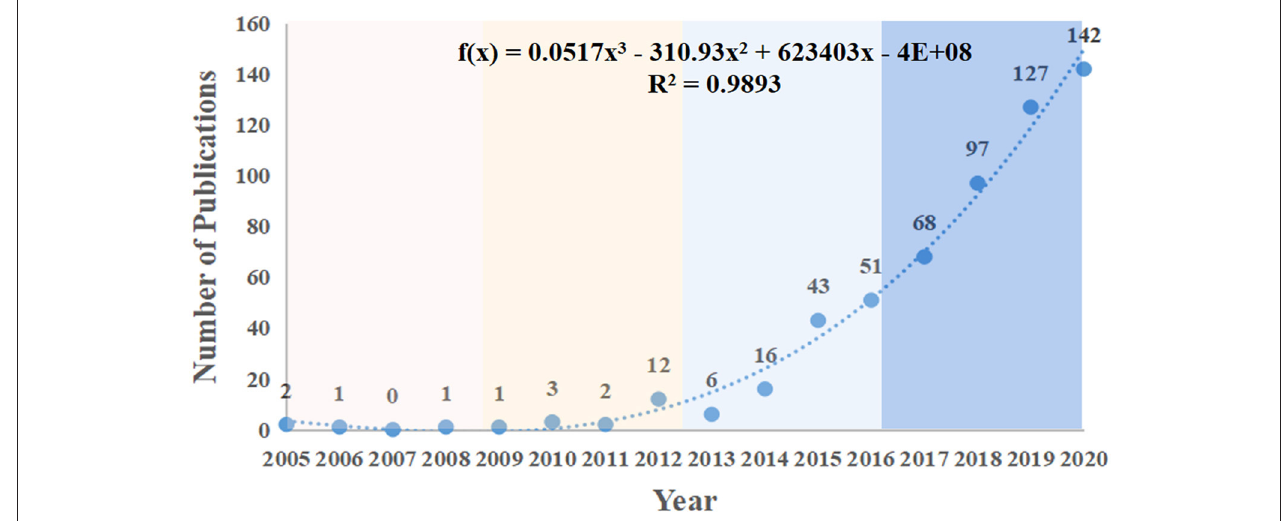
FIGURE 2 | The output of publications and growth trends of HIIT in health promotion fields.